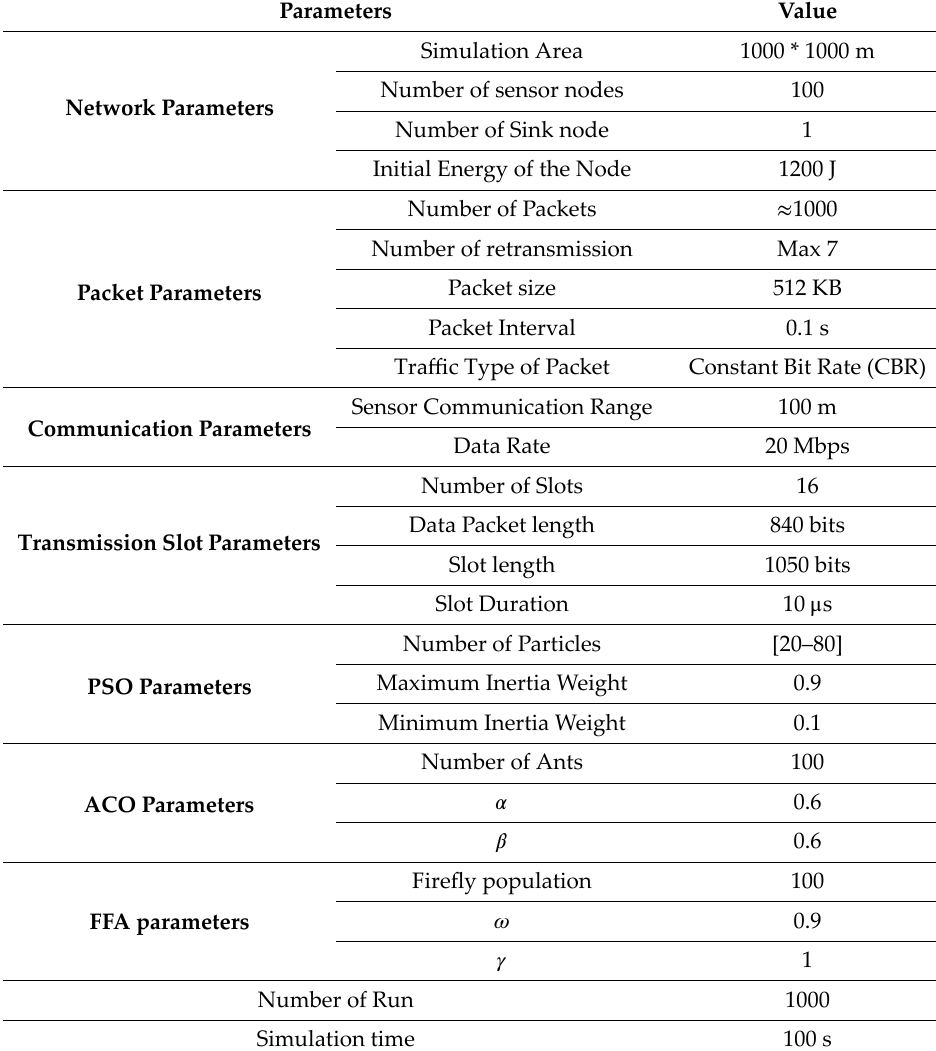
Table 2. Simulation